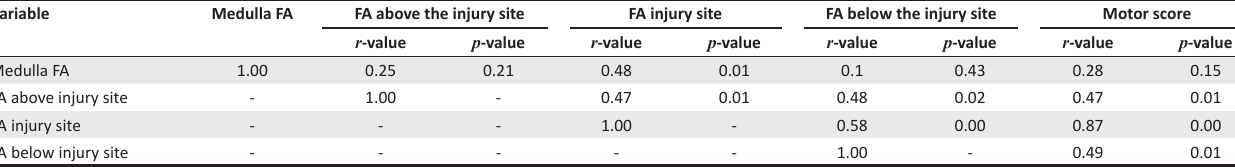
TABLE 2 : Comparison of the findings using Spearman’s correlation coefficient